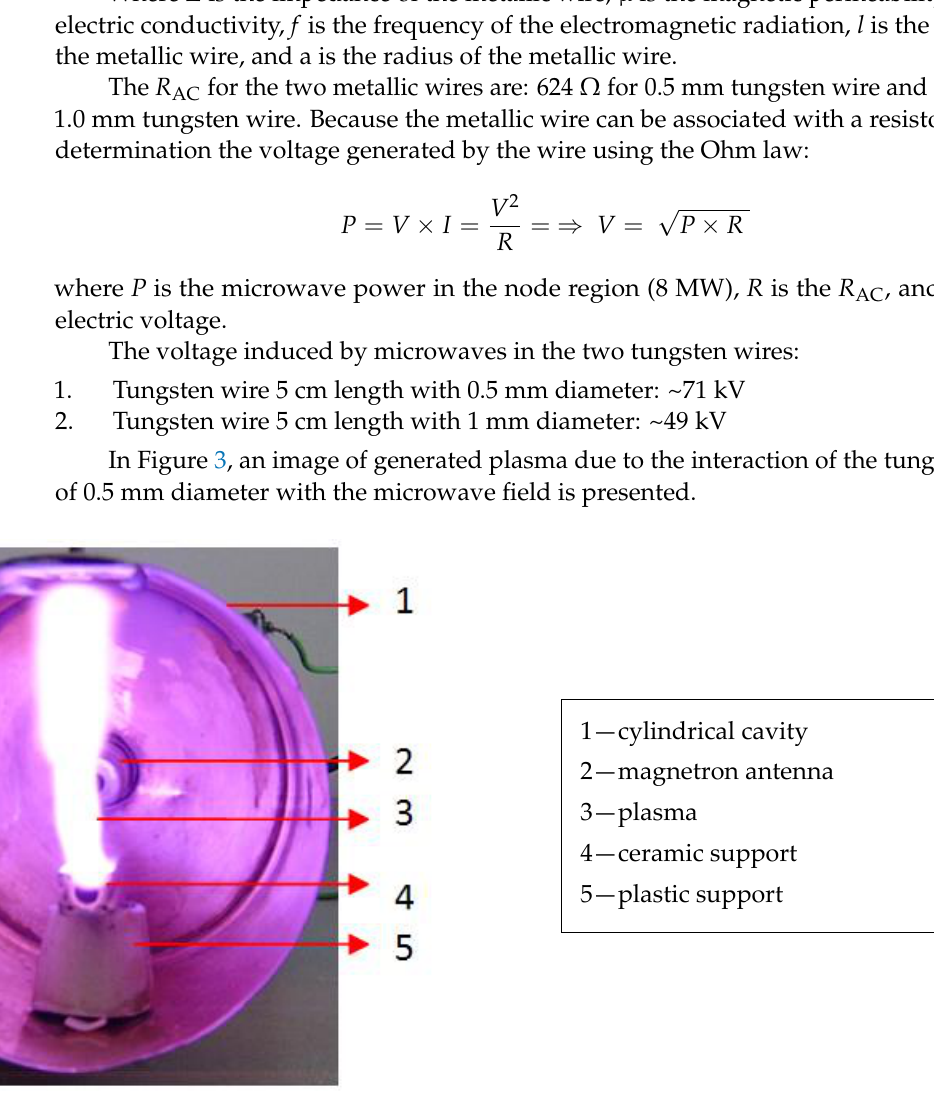
Figure 3. Image of the generated plasma when the 0.5 mm diameter metallic wire was exposed to the microwave field.